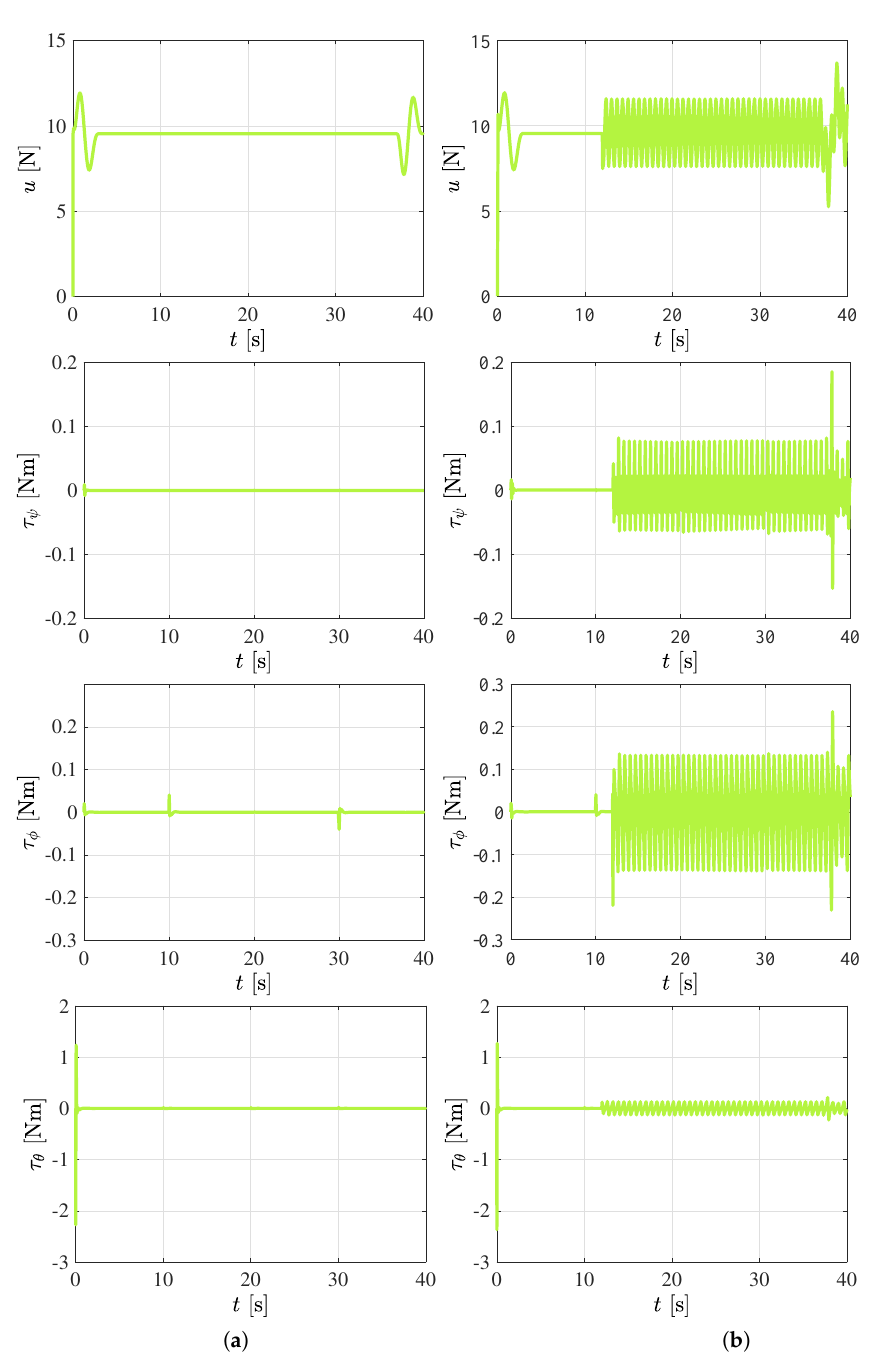
Figure 9. Computed control inputs in experiment 1. ( a ) Unperturbed. ( b )